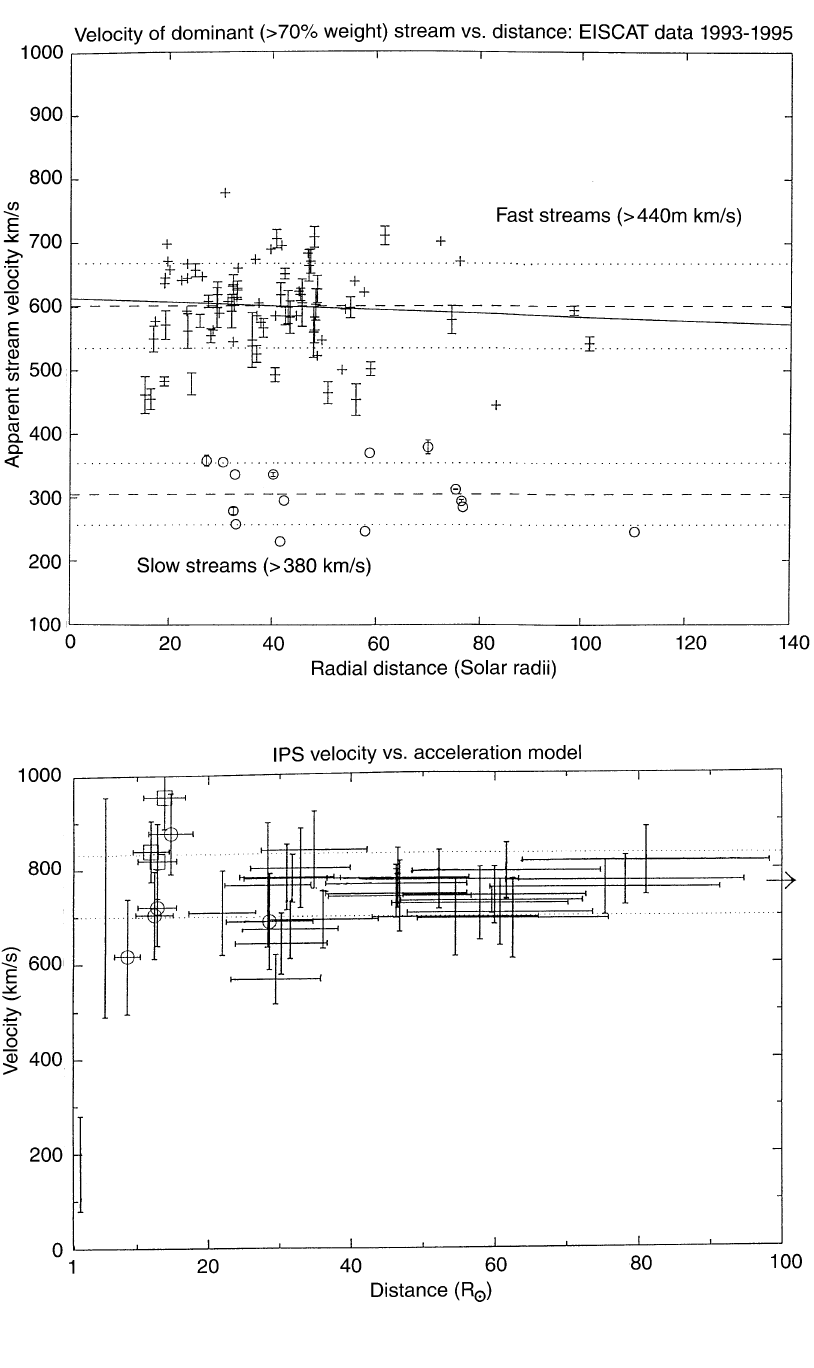
Fig. 5. Variation with radial distance of the apparent velocity of clearly dominant streams (contributing ’ 85% of scattering) in data from 1993 — 1995